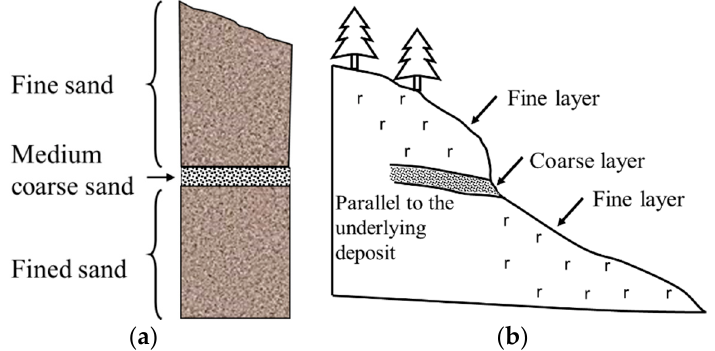
Figure 1. ( a ) Schematic profile of a multi-layered slope; ( b ) a description of the geometry of a multi-layered slope .